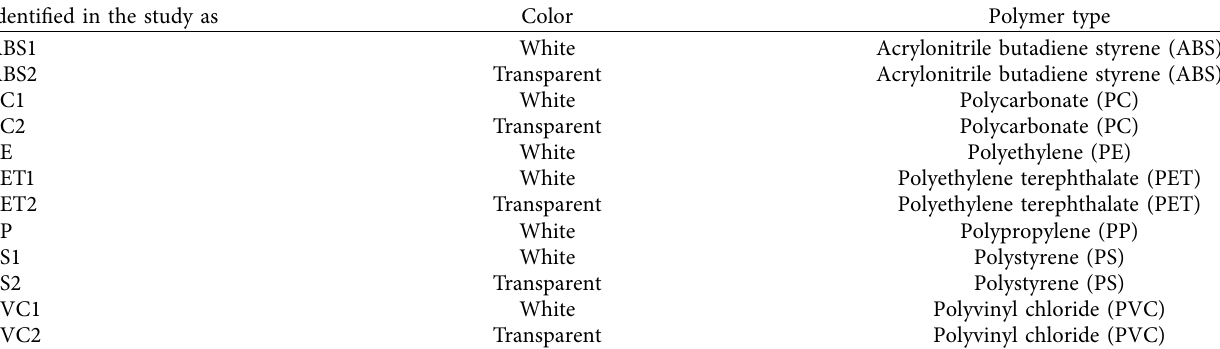
Table 1: Description of the standard plastic samples.